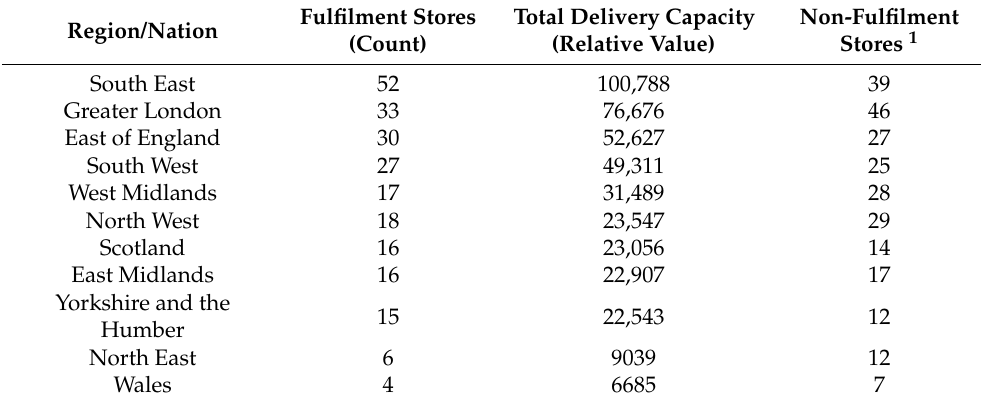
Table 2. Online delivery capacity, fulfilment stores and potential for store-based fulfilment by